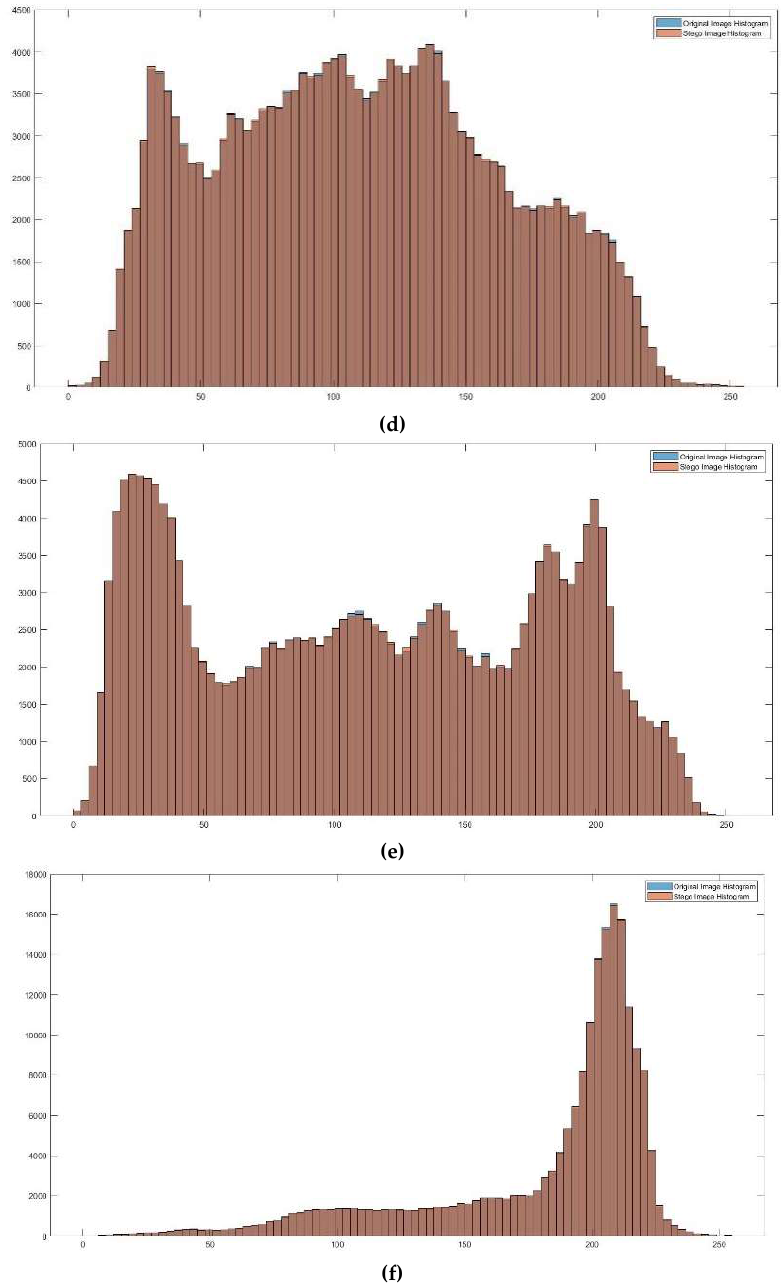
Figure 10. Original image with stego image histograms. Histograms of original and ( a ) stego Lina image; ( b ) stego baboon image; ( c ) stego pepper image; ( d ) stego Barbara image; ( e ) stego sailboat image; ( f ) stego airplane image.